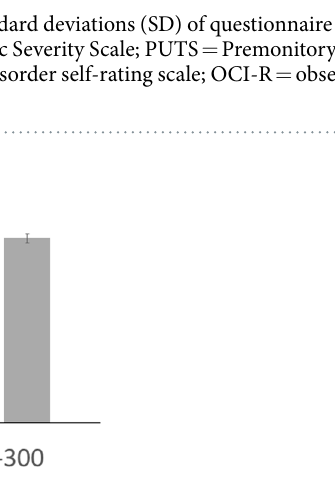
Figure 1. The figure displays accuracy (mean ± standard error) information for the stop change 0 ms delay condition (SCD-0) on the left and the 300 ms delay condition (SCD-300) on the right. * p <